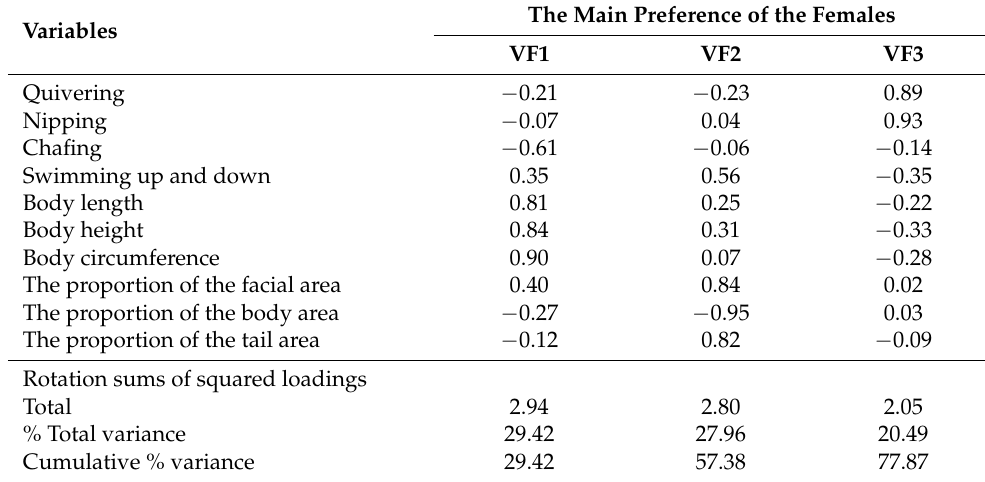
Table 7. The main preference features of females in mate choice in A. rivulatus